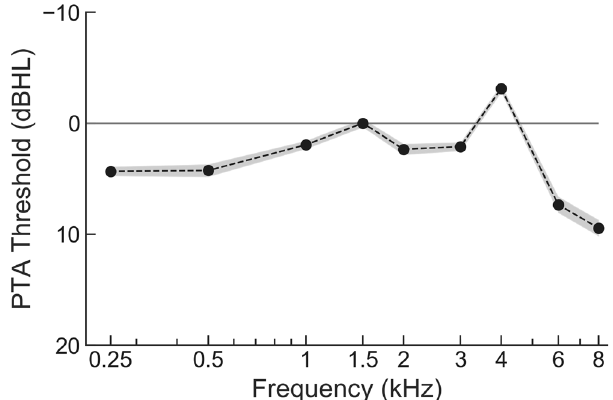
Figure 2. Audiometric thresholds. All participants have normal hearing: their hearing thresholds averaged over the left and right ear are below 10 dBHL (black dots: population mean, grey shading: population standard error of the